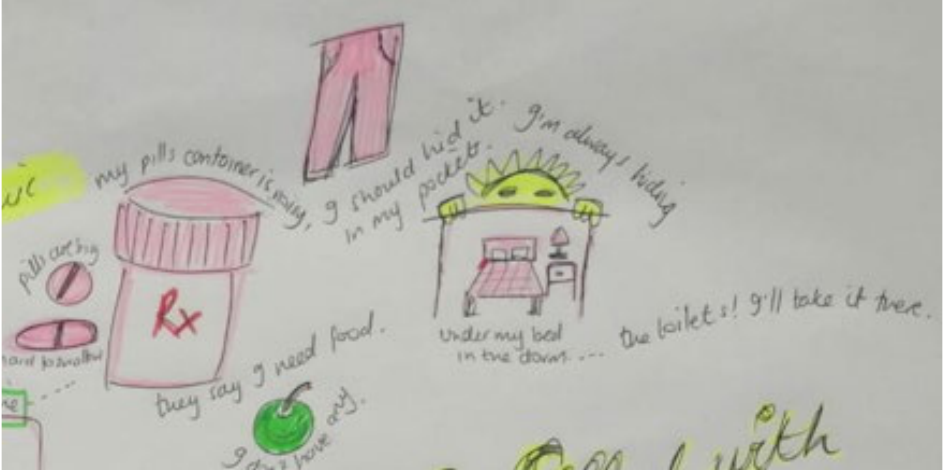
Figure 12. Pills, food, and school.